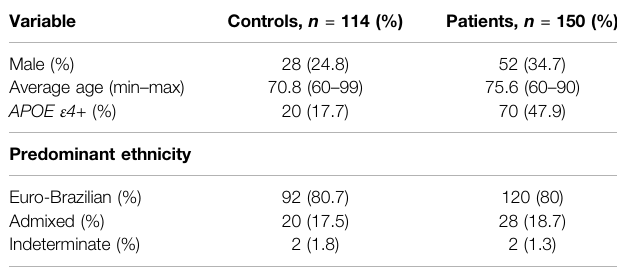
TABLE 1 | Demographic and clinical characteristics of research